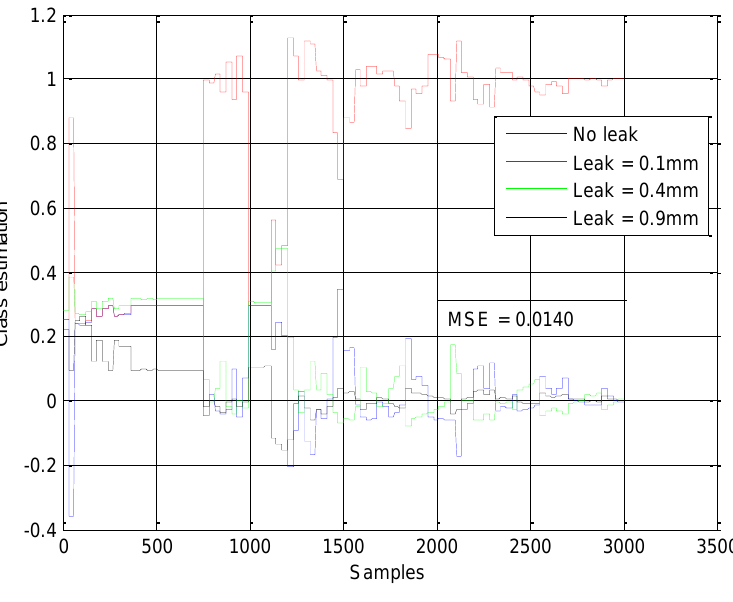
Figure 11. Leak Characterization in “Low Leakage” case.